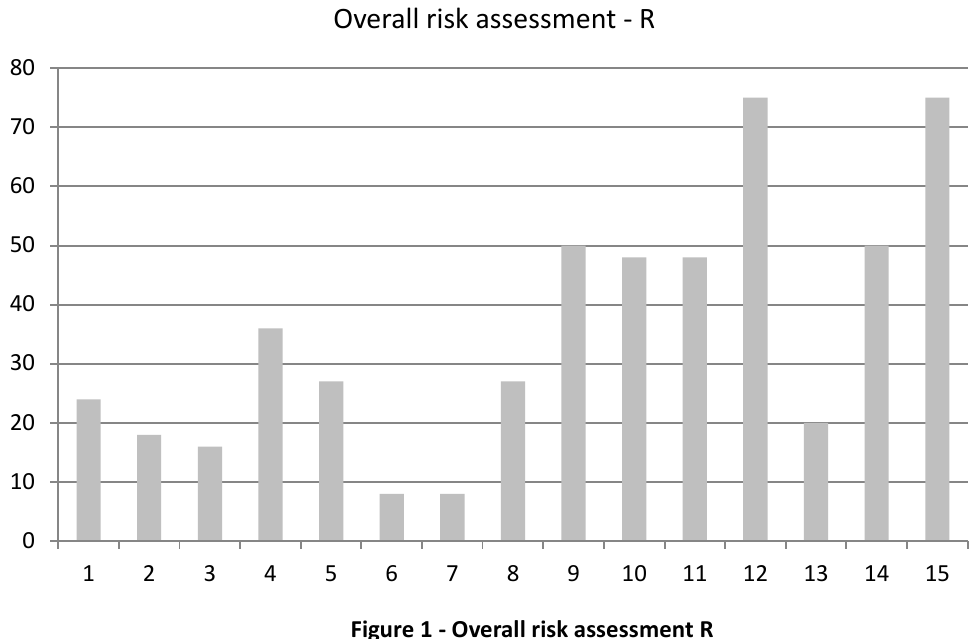
Figure 1 - Overall risk assessment